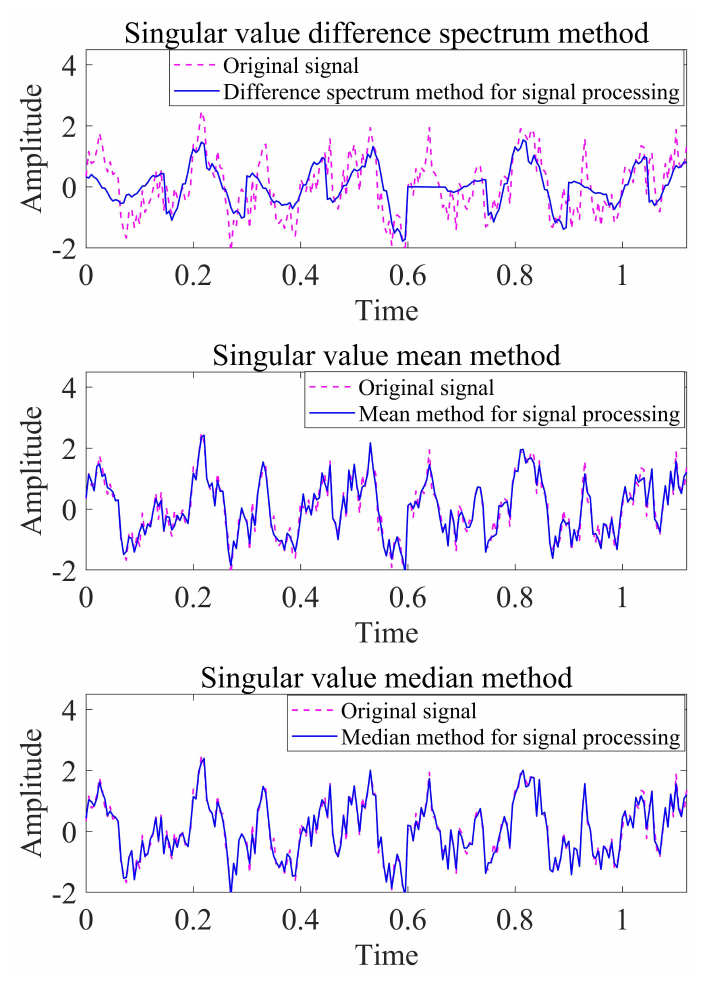
Figure 1. Effect diagram of three methods of noise